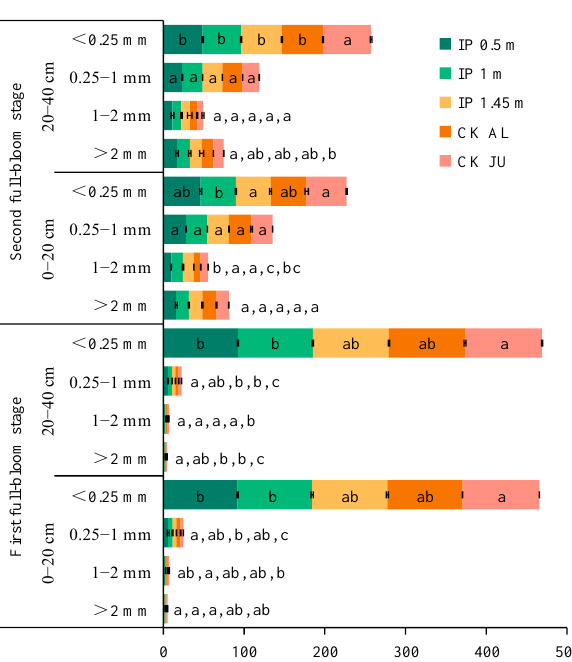
Figure 4. Distributions of soil water-stable aggregates (SWSA) for soil samples taken at the two depths during the first and second full-bloom stages. The letters for each bar segment denote the significant differences between the treatments at a given size of the aggregate.